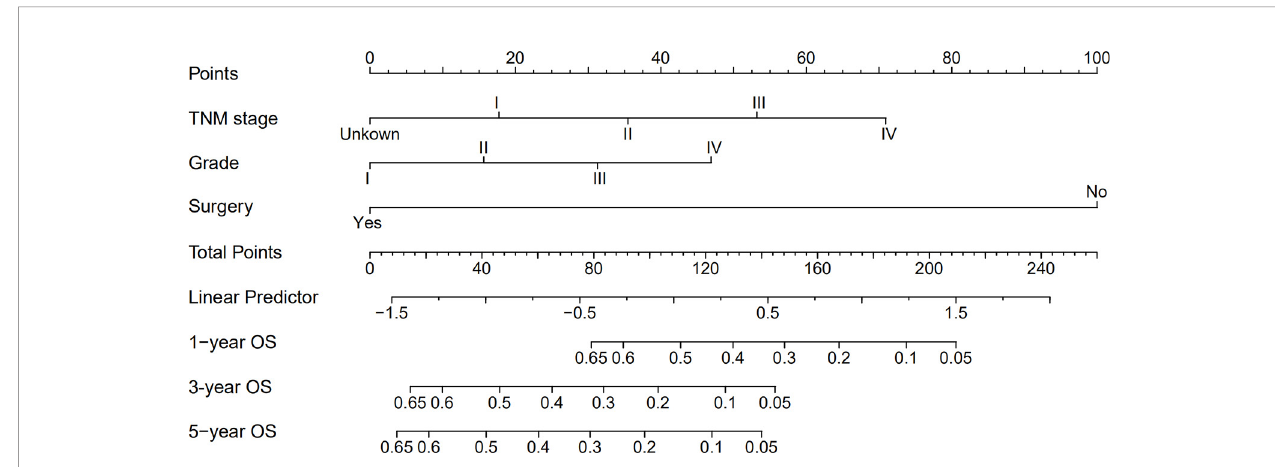
FIGURE 2 | Nomogram for predicting 1-, 3- and 5-year overall survival (OS) of combined hepatocellular cholangiocarcinoma